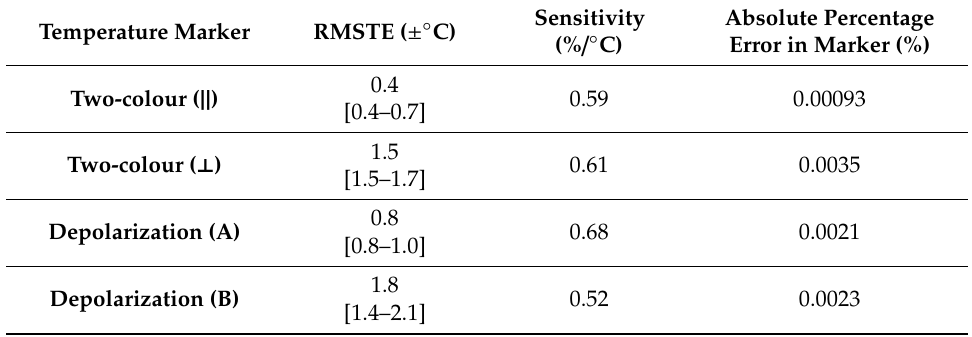
Table 2. RMSTEs, sensitivities, and the absolute percentage errors in each marker for a Milli-Q water sample. Data in brackets is based on the analysis of 4 datasets; data without brackets is based on the “average markers” dataset. Refer to Section 2.1. for